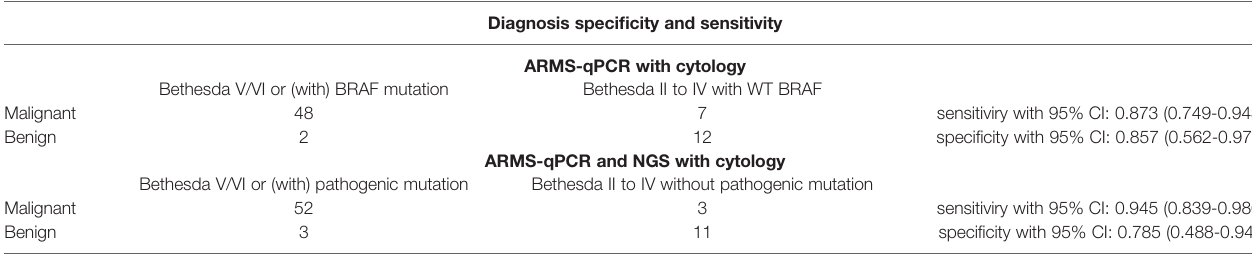
TABLE 5 | Diagnosis ef fi ciency of combined diagnostic